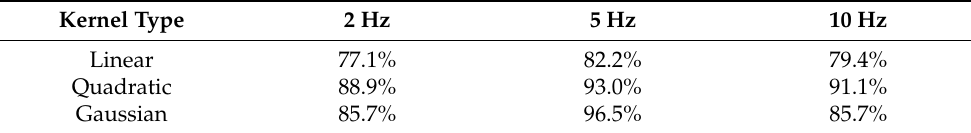
Table 4. Accuracy of each single-frequency hammering in the four-category classification.